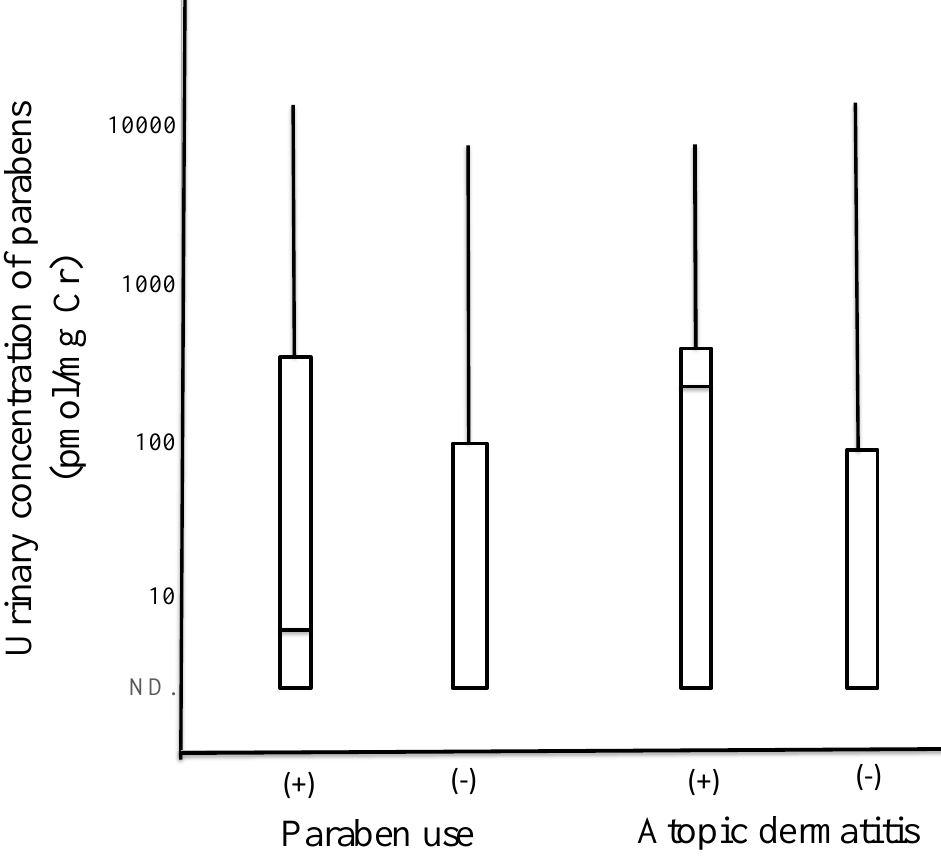
Figure 1. Comparisons of the distribution of urinary concentrations of parabens between children with and without paraben use ( left ) and between children with and without atopic dermatitis ( right ). Each boxplot represents maximum, 75th percentile, median, 25th percentile, and minimum.